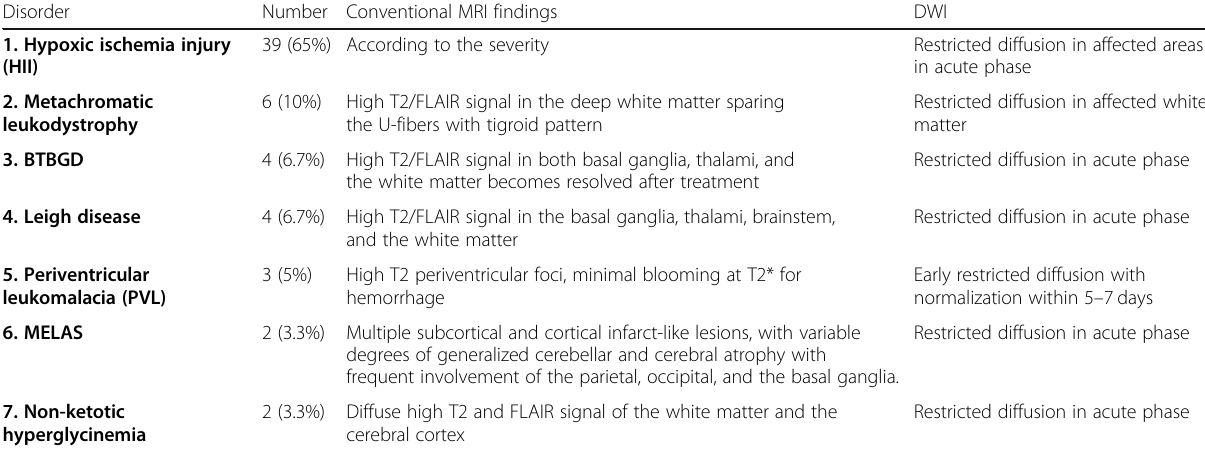
Table 2 General MRI findings of the selected group patients ( n = 60)